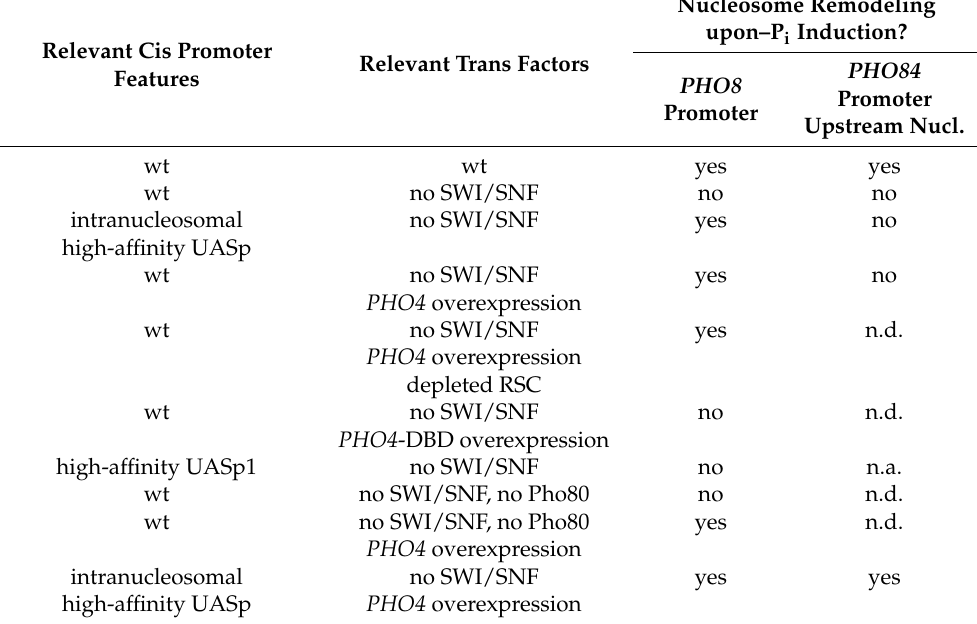
Table 1. Summary of main